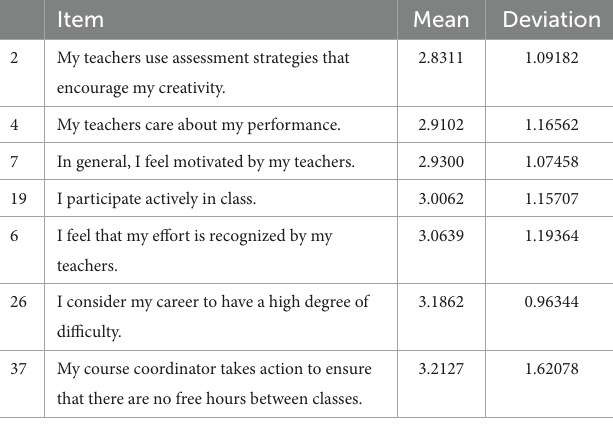
TABLE 4 Items with lower scores for early childhood education and primary education